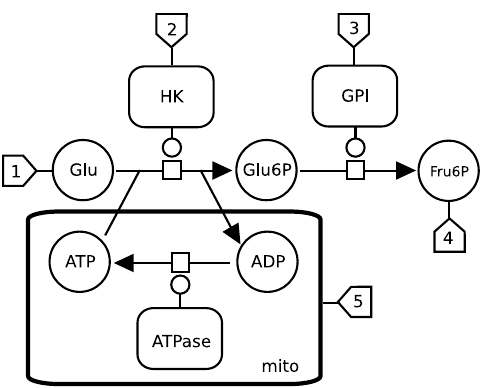
Figure 2.24: Example of an unfolded submap. The unfolded submap corresponds to the folded submap of Figure 2.23 on the preceding page.